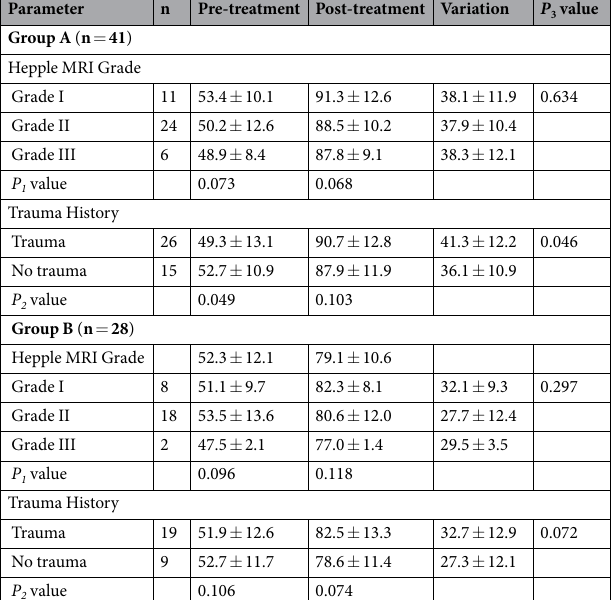
Table 3. The results of American Orthopaedic Foot and Ankle Society (AOFAS) score and its variation after treatment by trauma history and MRI grade within each group. Note: P 1 value: comparison of data among Hepple MRI Grade groups for AOFAS score of pre-treatment and post-treatment. P 2 value: comparison of data between trauma group and no trauma group for AOFAS score of pre-treatment and post-treatment. P 3 value: comparison of data by trauma history and MRI grade for peri-treatment AOFAS score